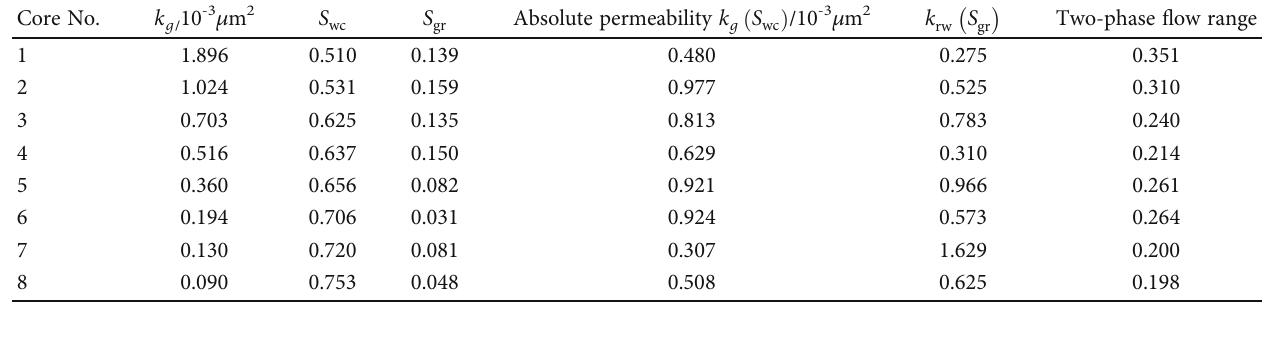
Table 2: Experiments results of the core samples.